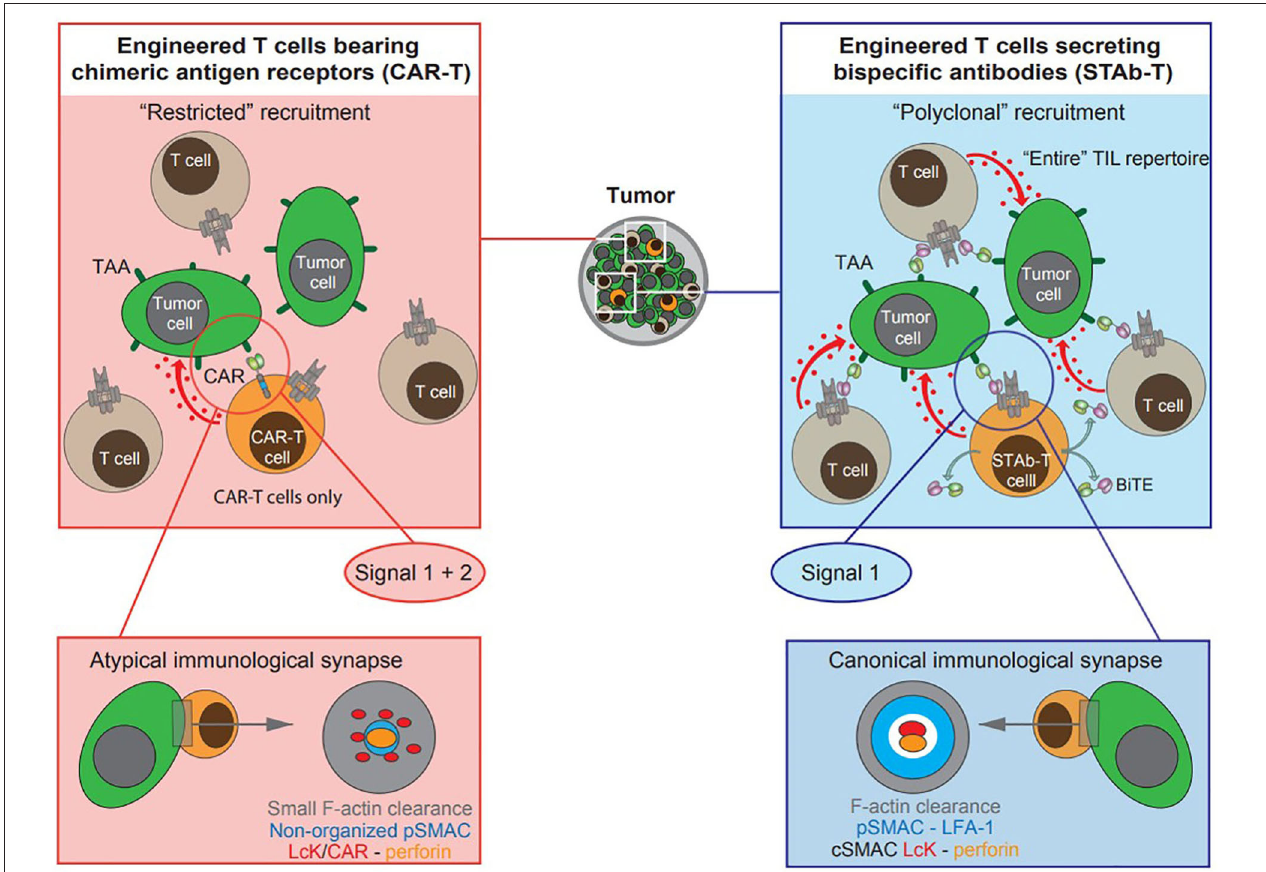
FIGURE 1 | Schematic diagram depicting cell-based T cell-redirecting strategies for cancer immunotherapy. Engineered T cells (orange cells) expressing second-generation scFv-based chimeric antigen receptors (CAR-T cells), and engineered T cells secreting T cell-redirecting bispecific antibodies (STAb-T cells) in BiTE format. The tumor-associated antigen (TAA)-specific scFv is displayed in light green and the anti-CD3 ζ scFv in magenta. Red arrows and dots represent delivery of the “lethal hit” to tumor cells (green cells) by CAR- or BiTE-activated T cells: engineered and/o bystander non-engineered tumor infiltrating T lymphocytes (TILs, gray cells). In engineered T cells expressing second generation CARs, a single molecular interaction provides both signals 1 and 2, whereas TAA-specific BiTEs do not provide co-stimulatory signaling to T cells. Topology observed in CAR-mediated and BiTE-mediated immunological synapse (IS): the CAR-mediated IS shows a rather disordered structure whereas the BiTE-mediated IS displays a well-organized canonical “bull’s eye”